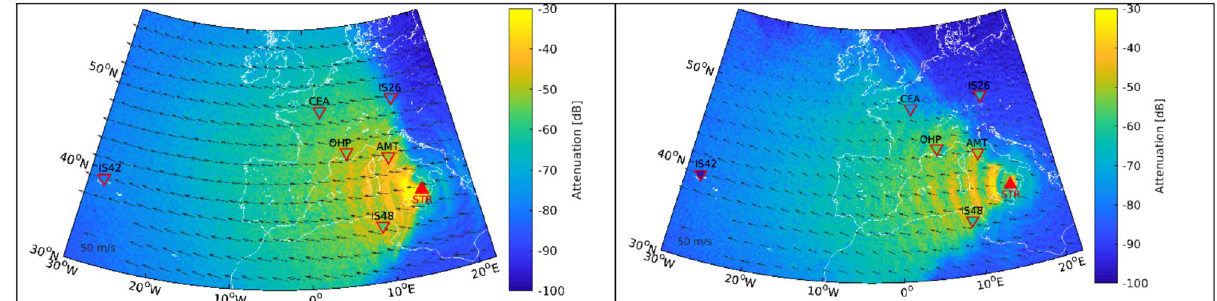
Figure 1. Attenuation maps derived from range dependent PE simulations at 1 Hz for the July 3rd (left) and August 28th (right) eruptions. Color-coded backgrounds represent the surface attenuation predicted by the PE model. The colored station markers represent attenuation of the array-observed amplitudes compared to a reference source amplitude at 1 km of 1510 Pa (July) and 466 Pa (August). For the sake of visibility, the northern most station IS37 is not included in the graphs. Table S2 provides details of the observed and modeled attenuation at all infrasound stations. The stratospheric wind field at 50 km altitude is represented by black arrows (50 m/s reference provided in the lower left corner). The map was generated using Matlab Mapping Toolbox Version 4.6 (https:// www. mathw orks. com/ produ cts).